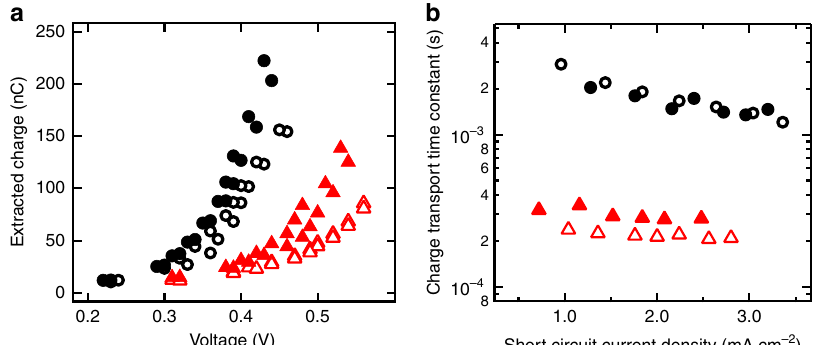
Figure 2 | Charge extraction and electron transport time constant. ( a ) Charge extracted at open circuit as function of the voltage for no treated samples (black) and Li-doped samples (red) and ( b ) charge transport lifetime as function of the short circuit current density for solid-state dye-sensitized solar cells prepared without and with Li-doped mesoporous TiO 2 (black and red markers, respectively). Two samples per condition are shown: open triangle, sample 1 Li-doped; closed triangle, sample 2 Li-doped; open circle, sample 1 no treated; closed circle, sample 2 no treated. For the charge extraction measurement ( a ), each sample was measured